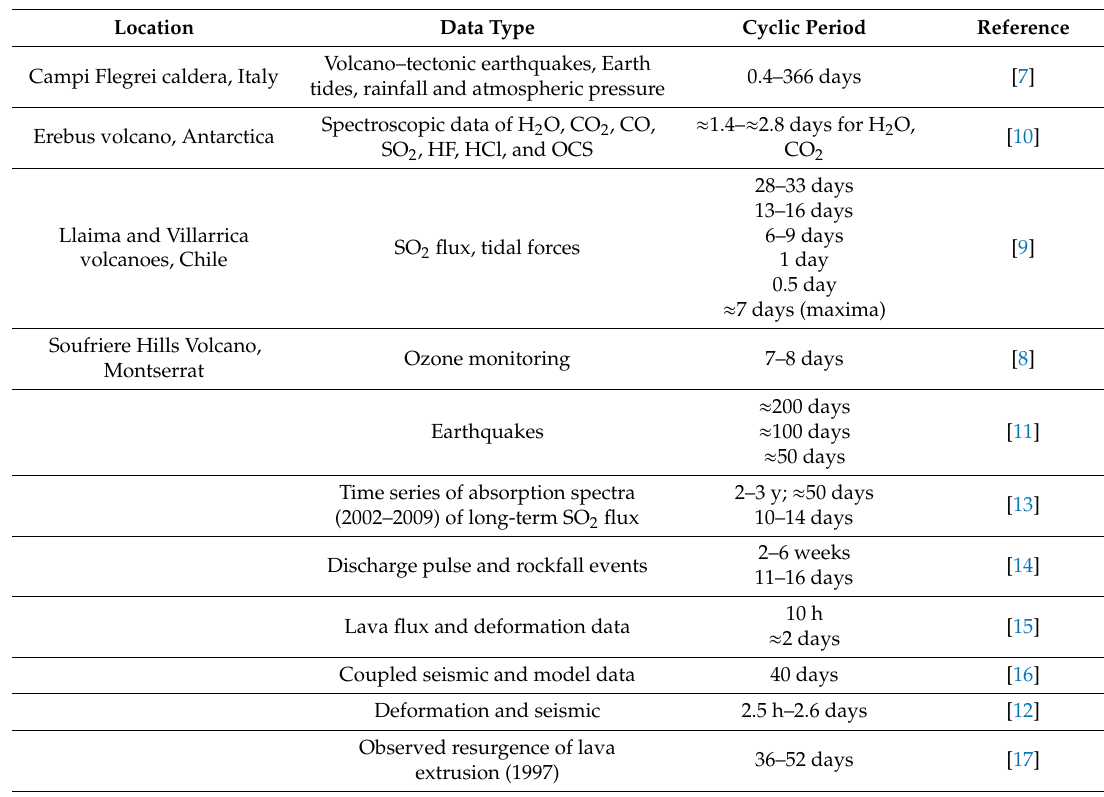
Table 1. Examples of cyclic periods identified in previous volcanic studies using di ff erent data sets (adapted and modified from